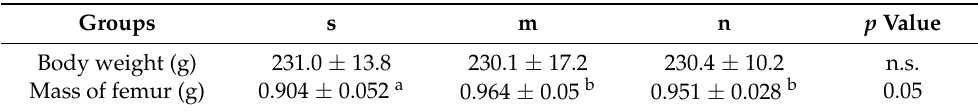
Table 2. Comparison of statistical differences in the body weights and femur weights of rats from different groups. Groups s Mass of femur